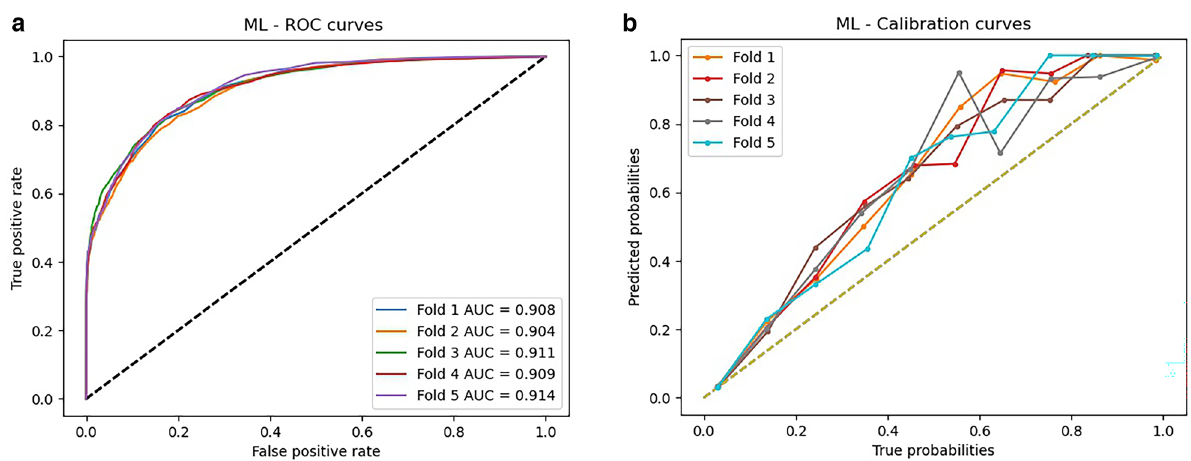
Figure 3. Random forest ( a ) area under the curve and ( b ) calibration curves for five outer validation folds. AUC—area under the